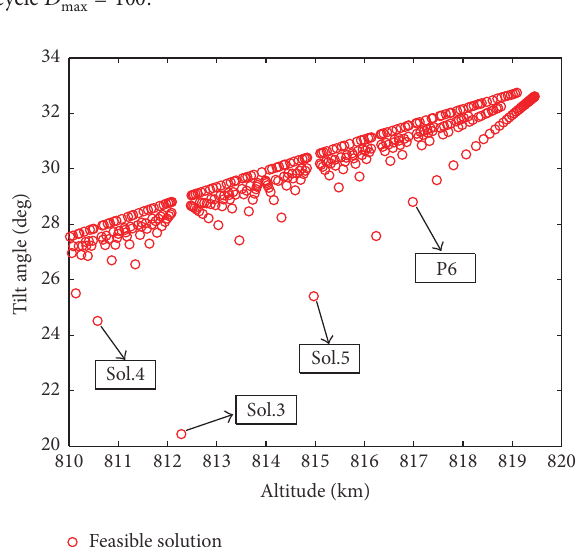
Figure 10: Feasible orbit solutions within RT des = 4 when repeat cycle 𝐷 max = 200